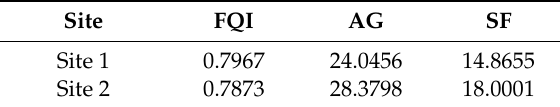
Figure 13. The experimental images in the additional dataset (Site 2): ( a ) TerraSAR-X image acquired on 8 August 2019, ( b ) GeoEye-1 image acquired on 19 August 2019, ( c ) fusion result of the proposed method. Table 5. Evaluations of the additional dataset (FQI: fusion quality index, AG: average gradient, SF: spatial frequency).